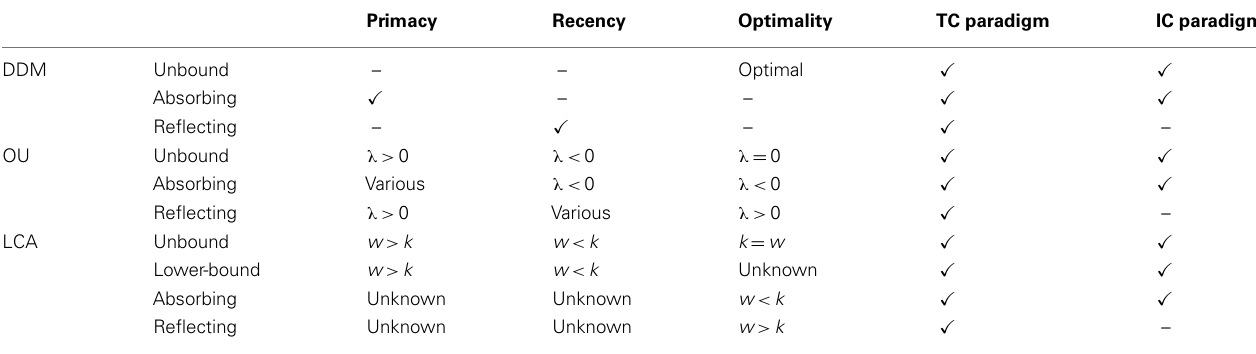
Table 1 | Properties of the sequential sampling models with and without